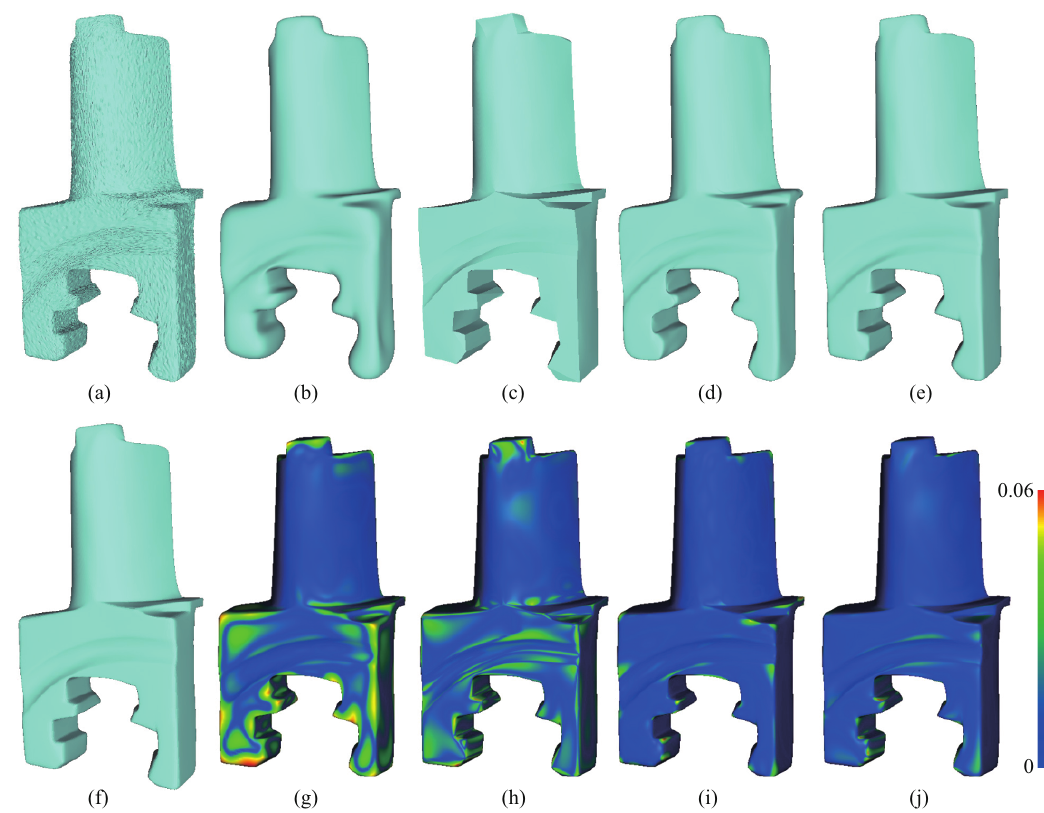
Fig. 9 Blade. (a) Input noisy model corrupted by Gaussian noise ( σ = 0 . 1¯ l e ) and 10% impulsive noise with scale 0 . 5¯ l e , (b–e) subdivision surfaces reconstructed using Loop subdivision, the rules in Ref. [2], the method of Ref. [25], and our method, (f) ground truth model, and (g–j) error distributions for (b–e)